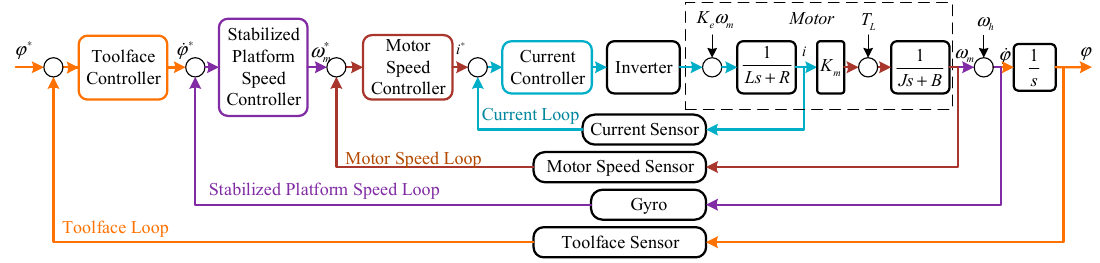
Figure 2. Structure of the RSS toolface control method .